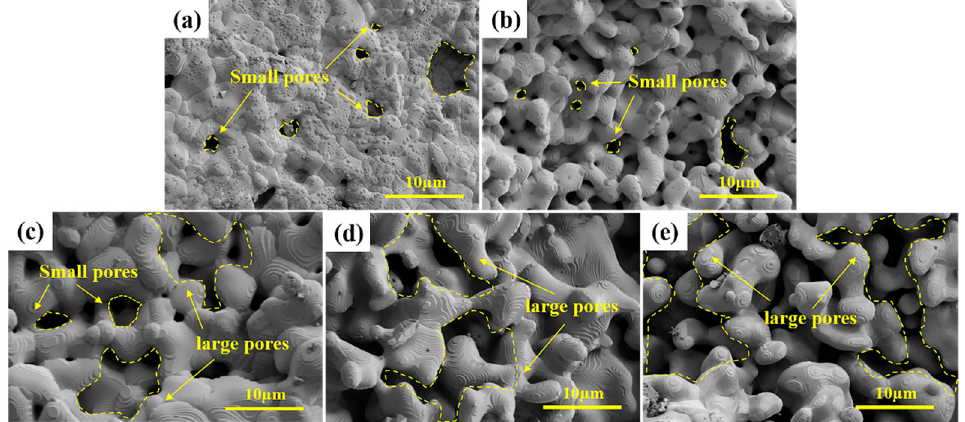
Figure 5. SEM images of the porous HECs with various amounts of pore-forming agents ( a ) HEC-1,